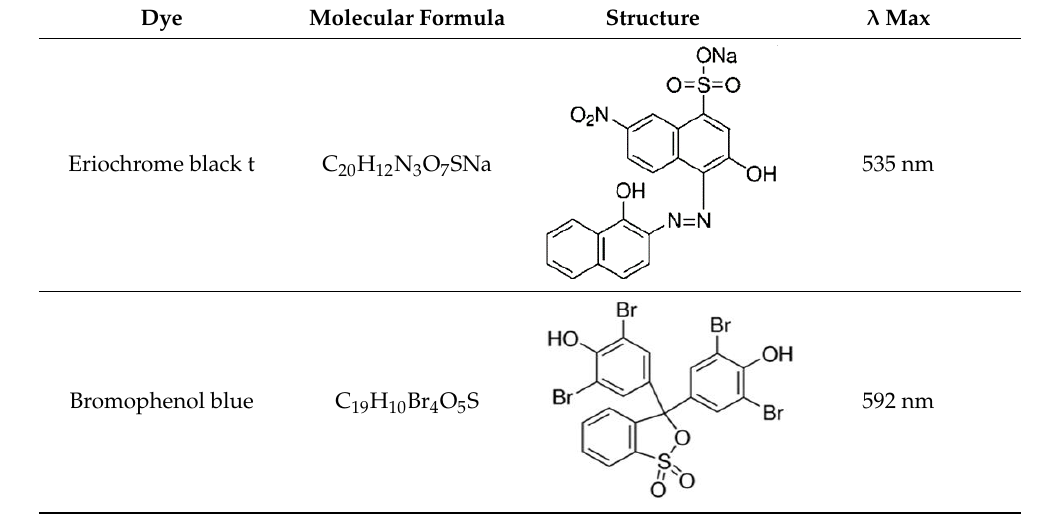
Table 1. Physico-chemical properties of Eriochrome black t and Bromophenol blue. Dye